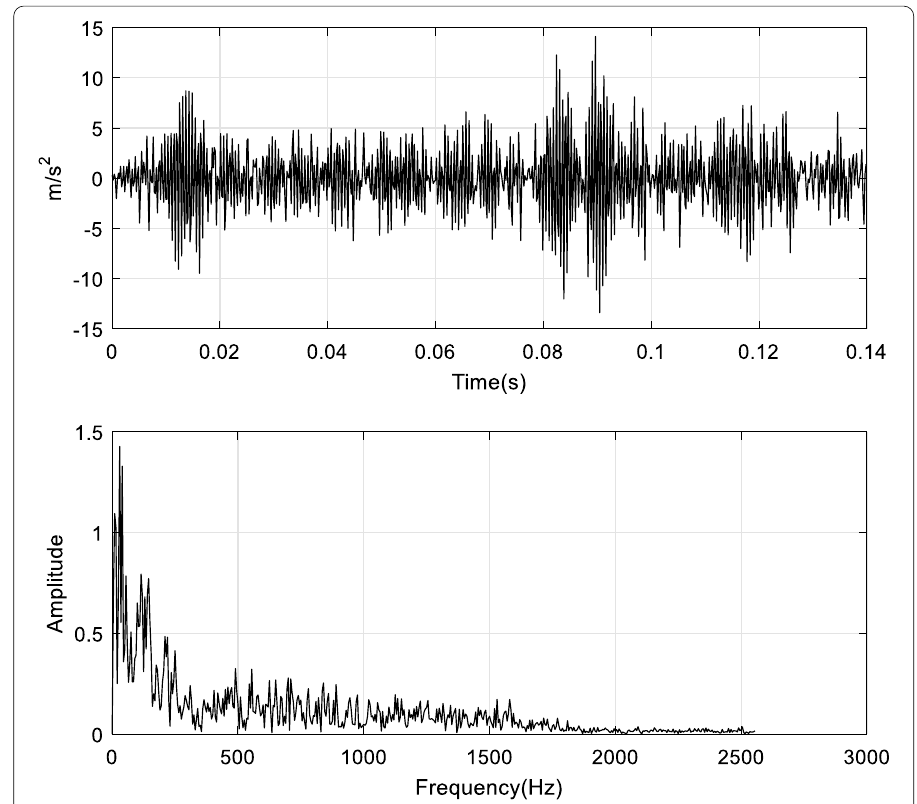
Fig. 14 Waveform and envelope spectrum of characteristic sub-band signal extracted by adaptive